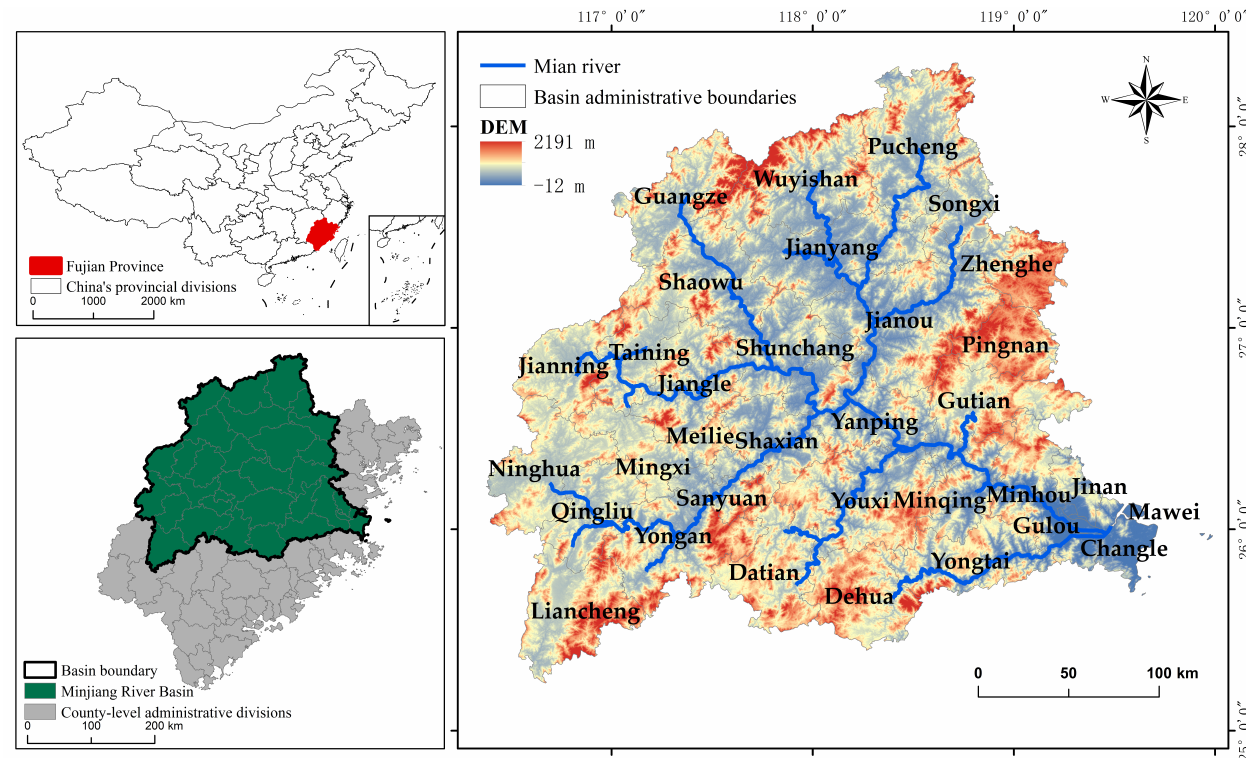
Figure 1. Geographical location of the study